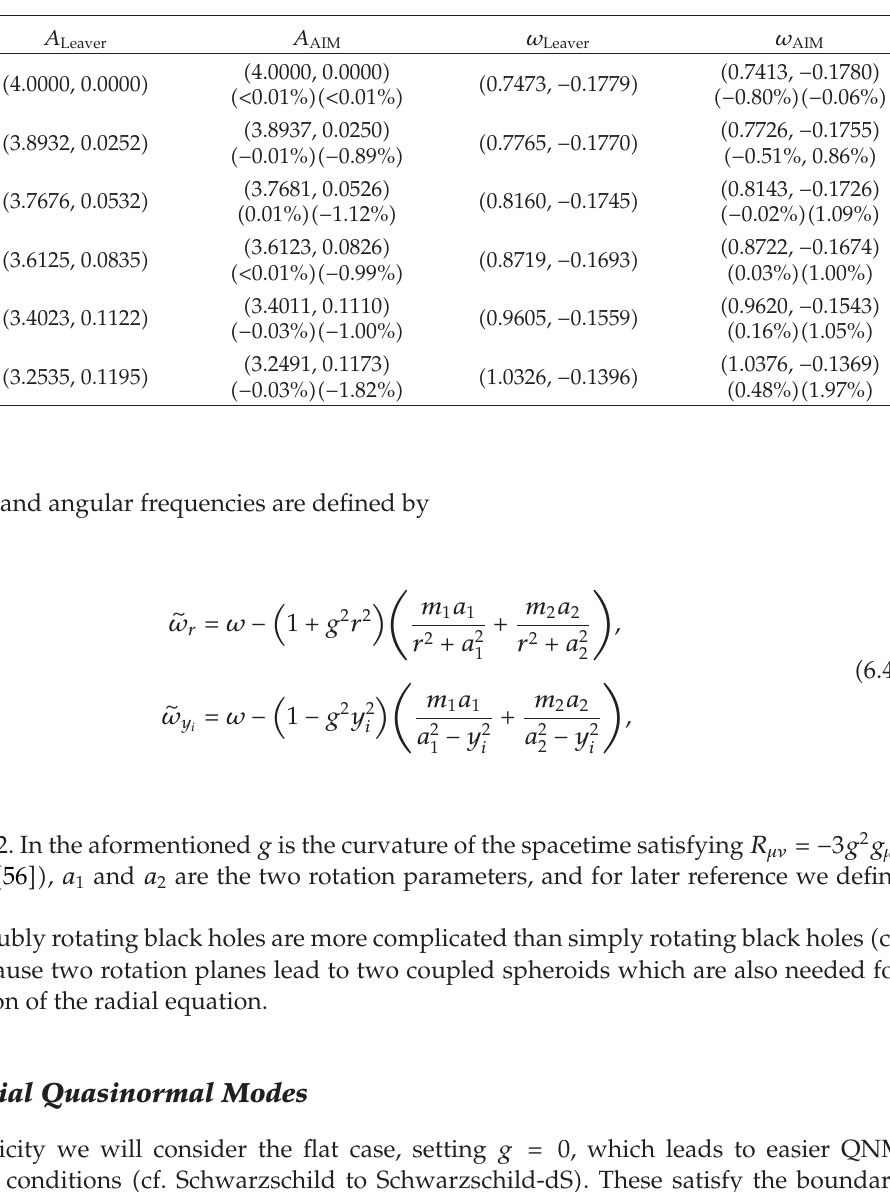
Table 12: Spin-2 angular separation constants and Kerr gravitational quasinormal frequencies for the fundamental mode corresponding to l (cid:8) 2 and m (cid:8) 1 compared with the CFM (cid:5) 6 (cid:6) (cid:2) M (cid:8) 1 / 2 (cid:3)